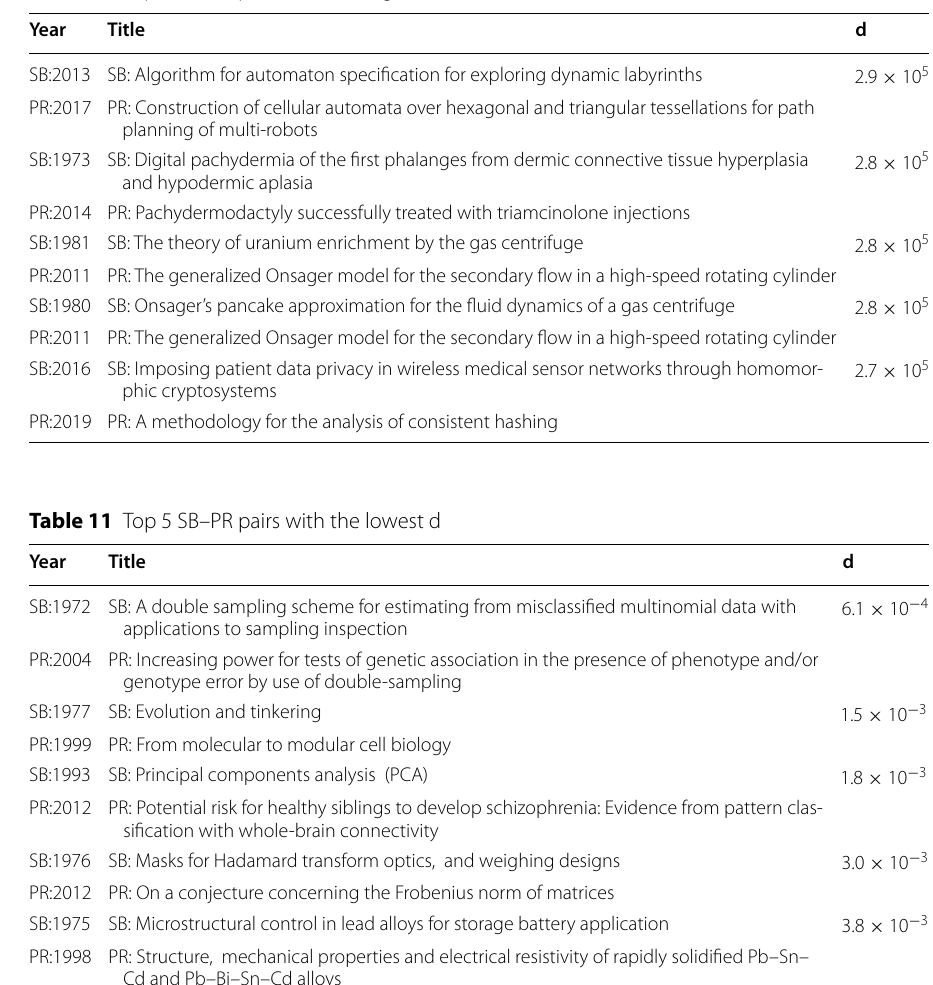
SB:1976 SB: Masks for Hadamard transform optics, and weighing designs SB:1975 SB: Microstructural control in lead alloys for storage battery application PR:1998 PR: Structure, mechanical properties and electrical resistivity of rapidly solidified Pb–Sn– Cd and Pb–Bi–Sn–Cd